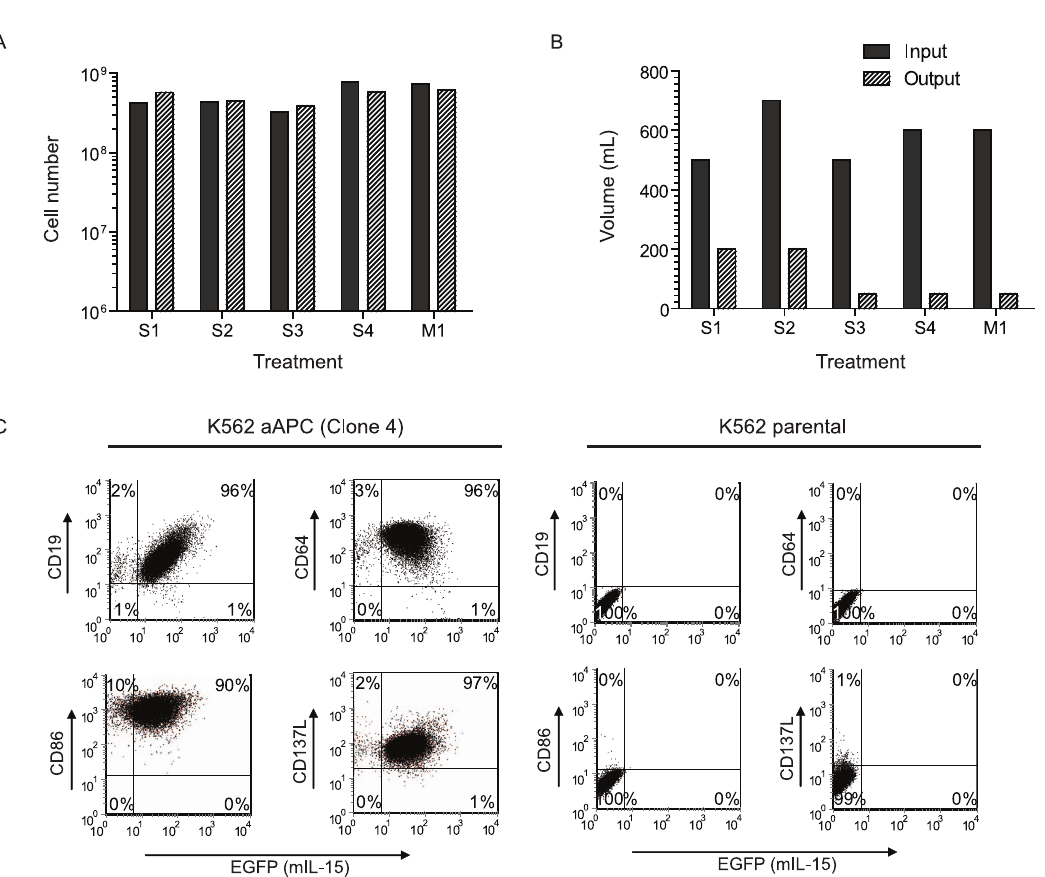
Figure 1. Harvest and characterization of aAPC. (A, B) Sepax volume reduction. aAPC clone # 4 grown in VueLife bags were harvested using CS- 490.1 kit in Sepax II. The Sepax harvest (S, n=4) was compared to manual (M, n=1) procedure. The mean pre/post-processing cell-counts (4.9 6 10 8 vs 5 6 10 8 ) were similar using the Sepax system. (C) Phenotype of aAPC (clone # 4). Flow cytometry analysis showing expression of CD19, CD64, CD86, CD137L and mIL-15 (expressed with EGFP) (mIL-15-EGFP) on K562 aAPC and K562 parental